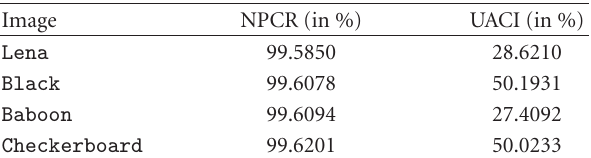
Table 1: Di ff erence measures between original and encrypted images.